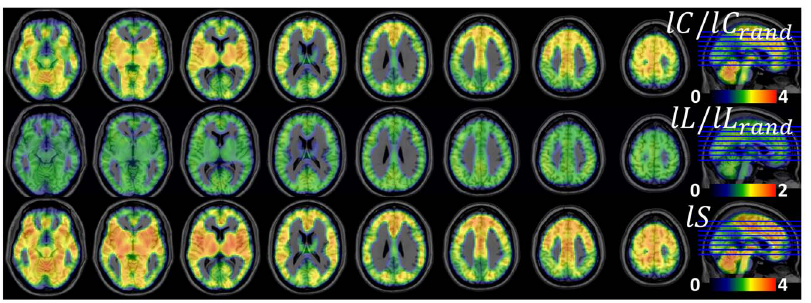
Figure 3. Regional measures of relative graph theory properties. Average measures of local clustering, l C/ l C rand , and characteristic path length, l L/ l L rand , relative to those of comparable random networks, and small-worldness, lS , for the networks functionally connected to each imaging voxel, superimposed on axial views of the human brain. Sample: 3 resting-state sessions from 40 healthy children (WashU dataset), correlation thresholds: R T1 = 0.40, 0.45 and 0.50; R T2 = 0.65, 0.70 and 0.75.